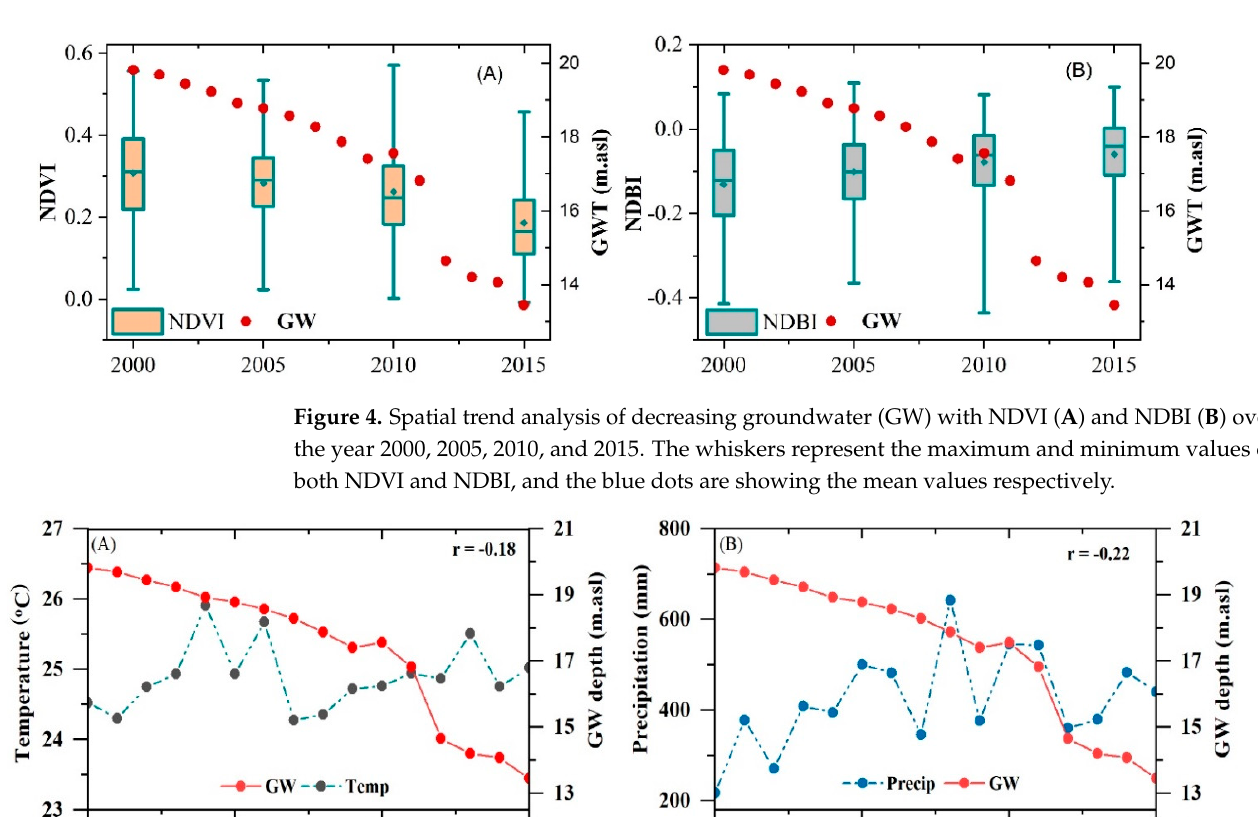
Figure 4. Spatial trend analysis of decreasing groundwater (GW) with NDVI ( A ) and NDBI ( B ) over the year 2000, 2005, 2010, and 2015. The whiskers represent the maximum and minimum values of both NDVI and NDBI, and the blue dots are showing the mean values respectively.